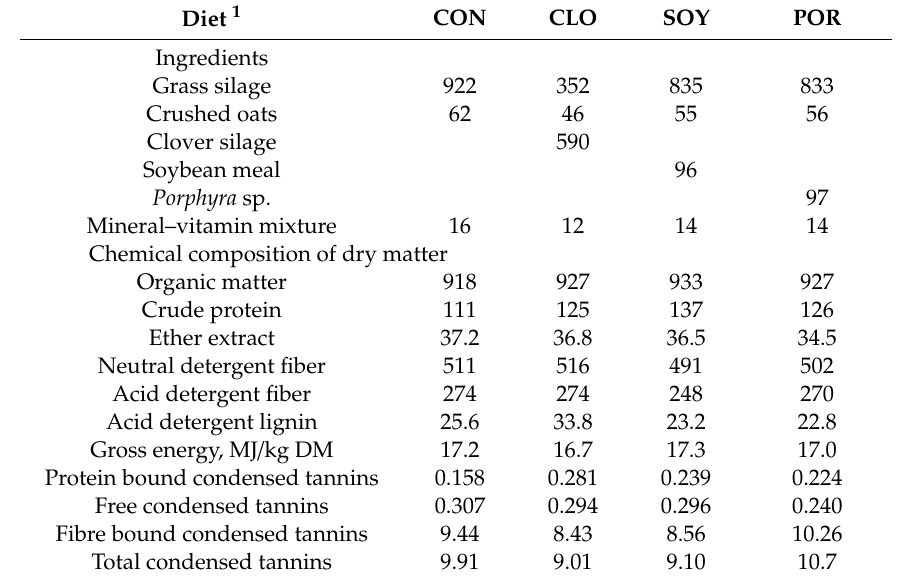
Table 2. Ingredients (g / kg fresh matter) and chemical composition (g / kg DM) of control and experimental